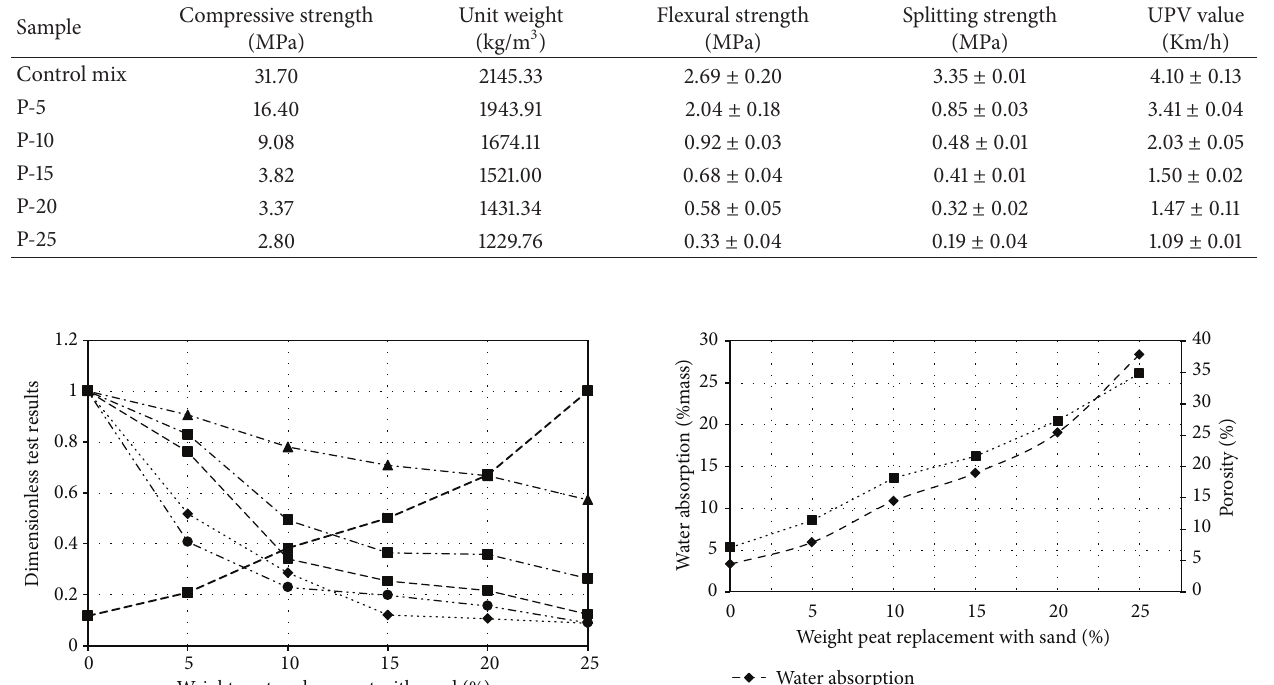
Table 3: Experimental values of the peat brick samples.